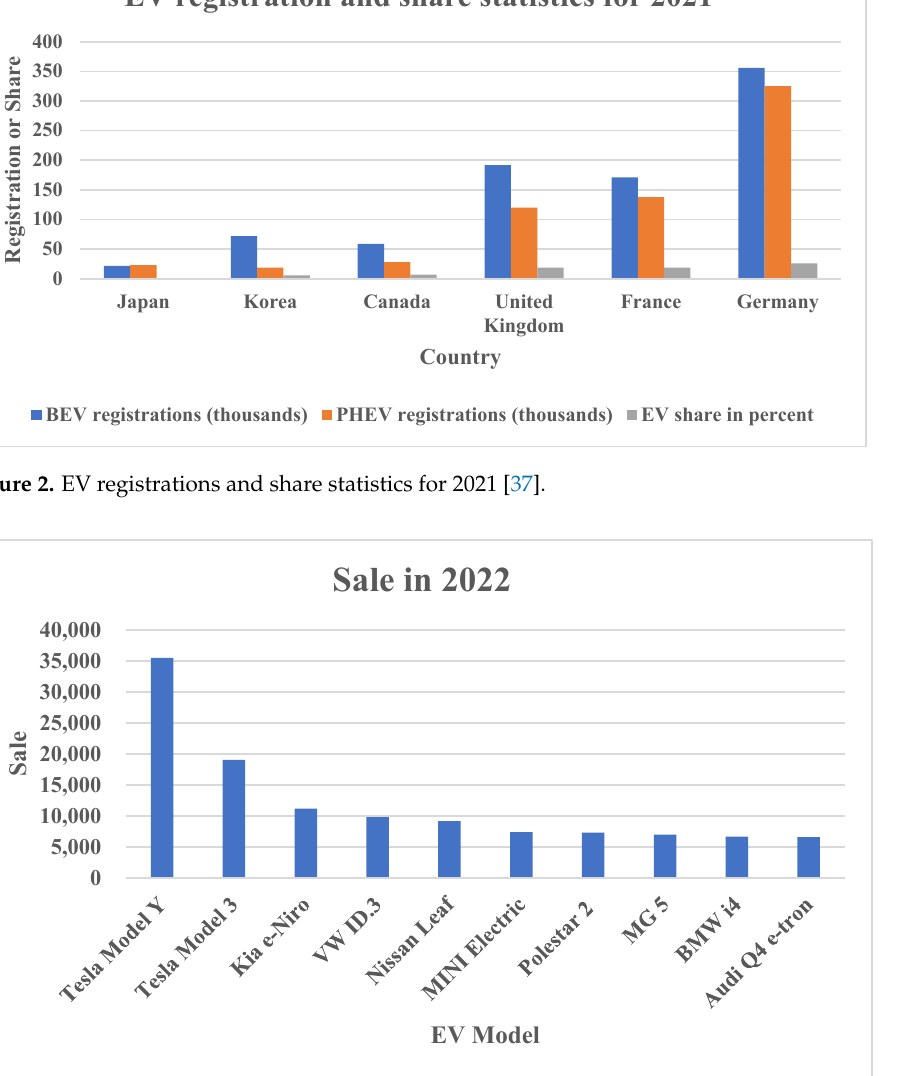
Figure 3. Sale of different EV models in 2022 [38].